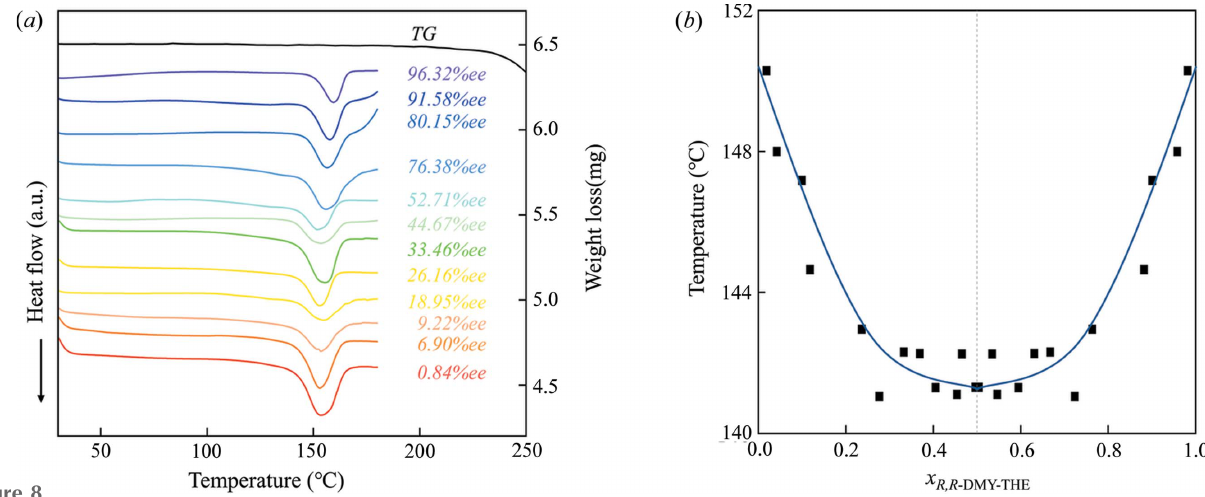
Figure 8 ( a ) TGA-DSC curves for the DMY–THE cocrystals at various ee . ( b ) Pseudo-binary melt phase diagram of DMY–THE